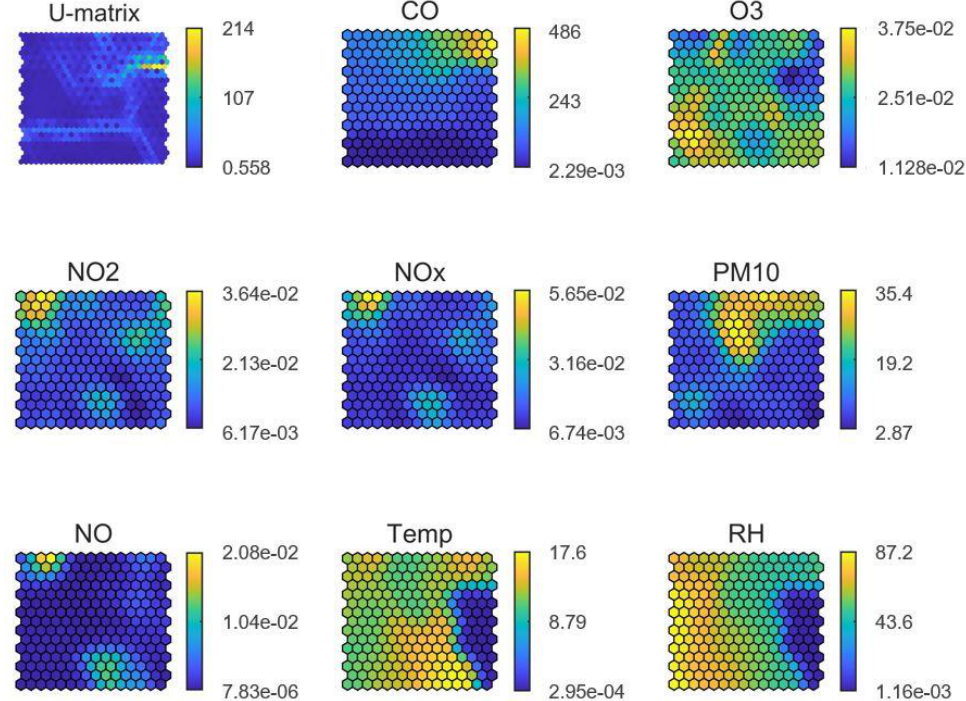
Figure 5. SOM of available data for stadium #1, in Europe. The colour scale is automatically adjusted among graphs and does not reflect the full range of values per parameter.